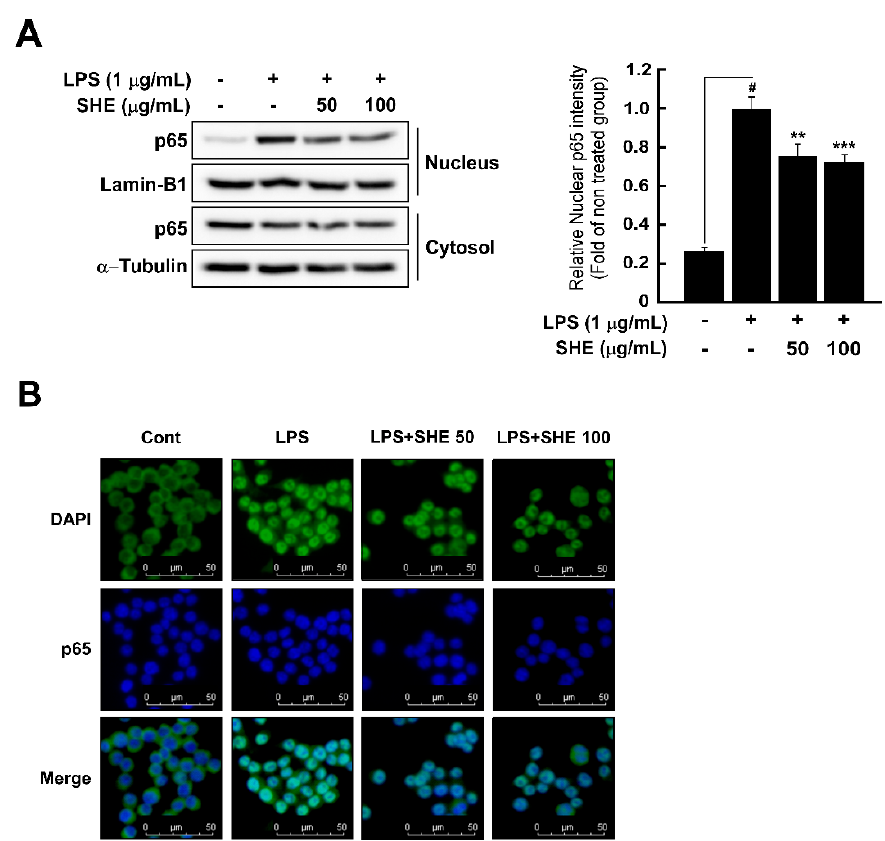
Figure 3. Effects of Soroseris hirsuta extract (SHE) on lipopolysaccharide (LPS)-induced p65 nuclear translocation in RAW 264.7 cells. ( A , B ) The p65 nuclear translocation induced by LPS was inhibited by SHE. ( A ) Western blotting, and the value obtained by quantifying the intensity of p65 in the nucleus of the Western blotting result, using image J. ( B ) Immunofluorescence measurement of p65 was performed as reported in the Materials and Methods, and cells were treated with SHE 1 h before exposure to LPS for 30 min. Data represent the mean ± SD of three independent experiments. # p < 0.05 between the control and LPS-exposed cells (no SHE); ** p < 0.01 and *** p < 0.001 between the control and LPS-exposed cells with SHE. N, nucleus; C, cytosol.